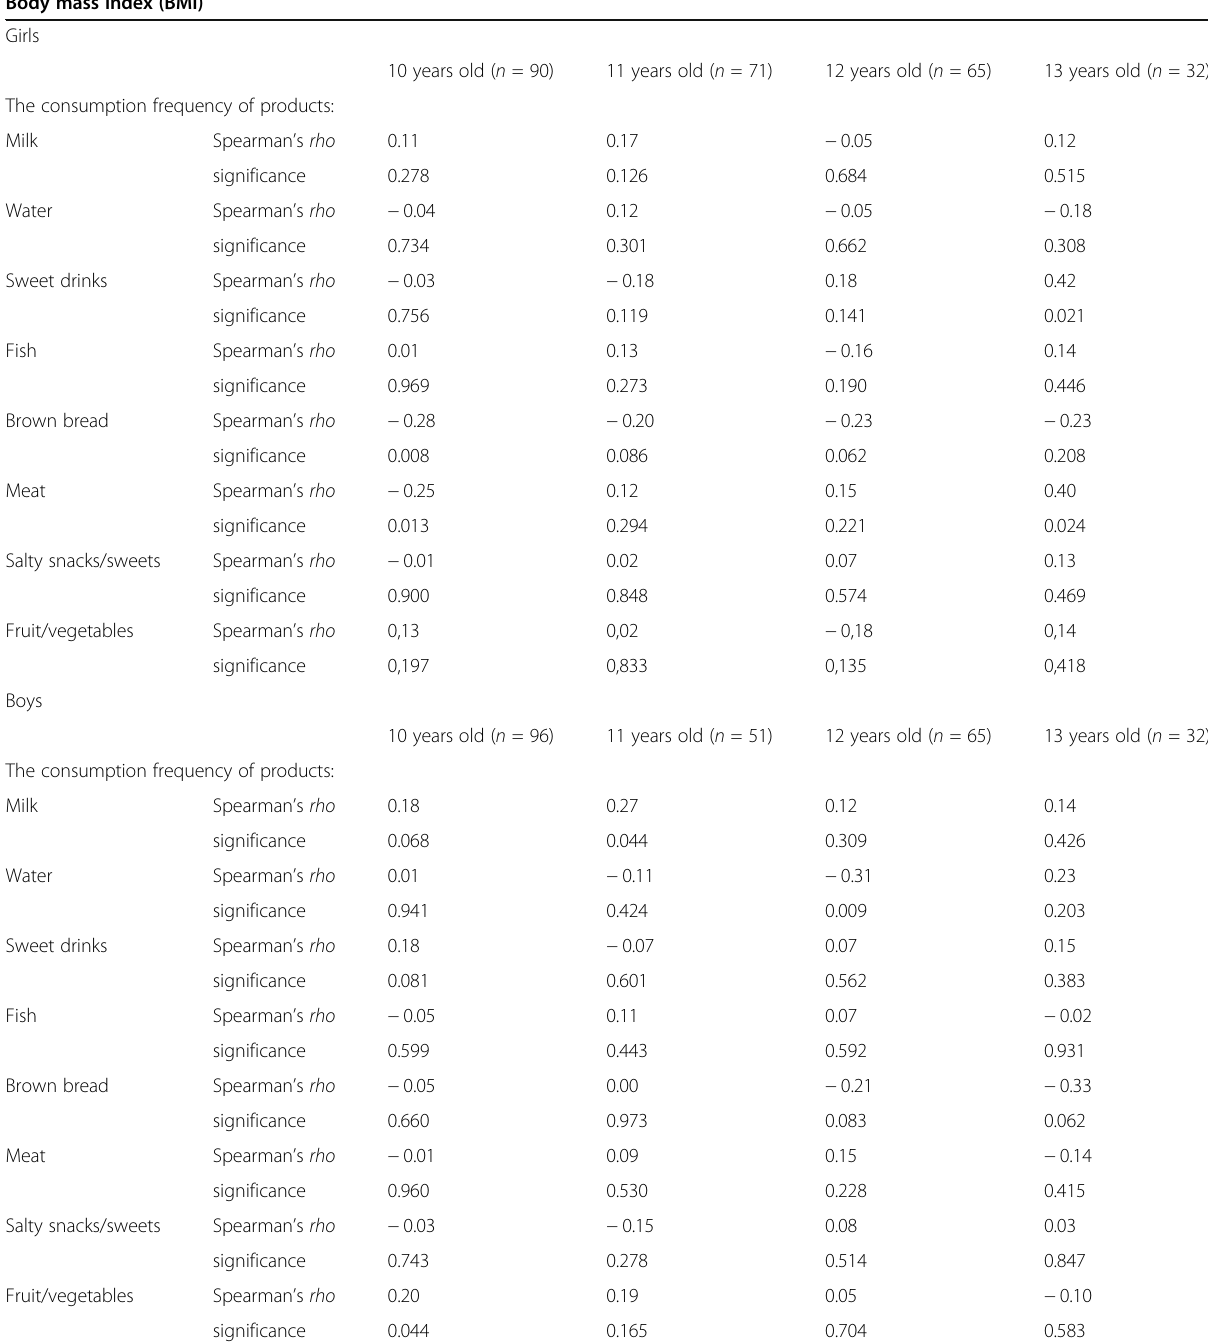
Table 8 The correlation between the frequency of the consumption of the specific food products depending on age and sex Body mass index